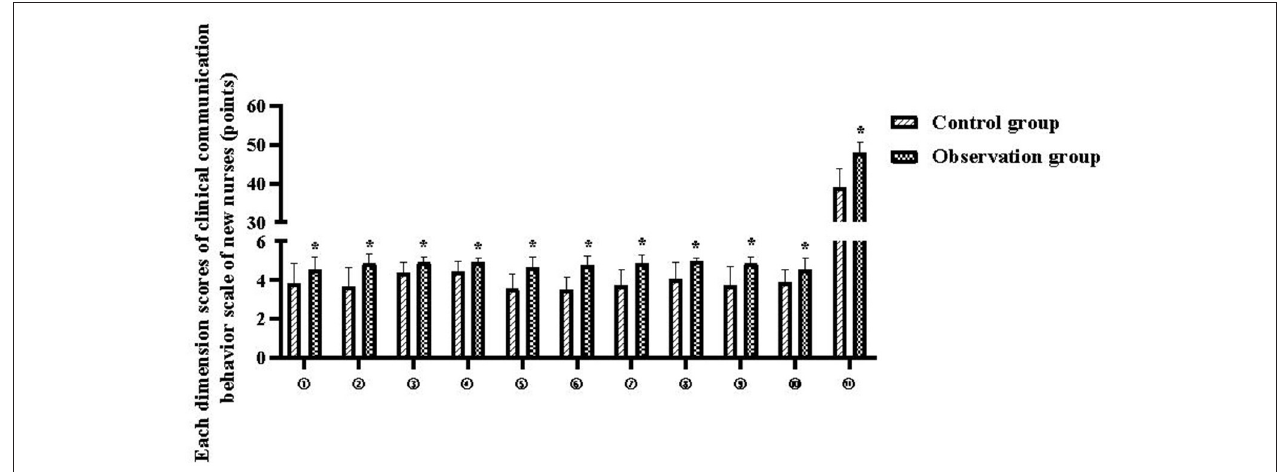
FIGURE 2 | Each dimension scores of clinical communication behavior scale of new nurses. Compared with the control group, * P < 0.05.